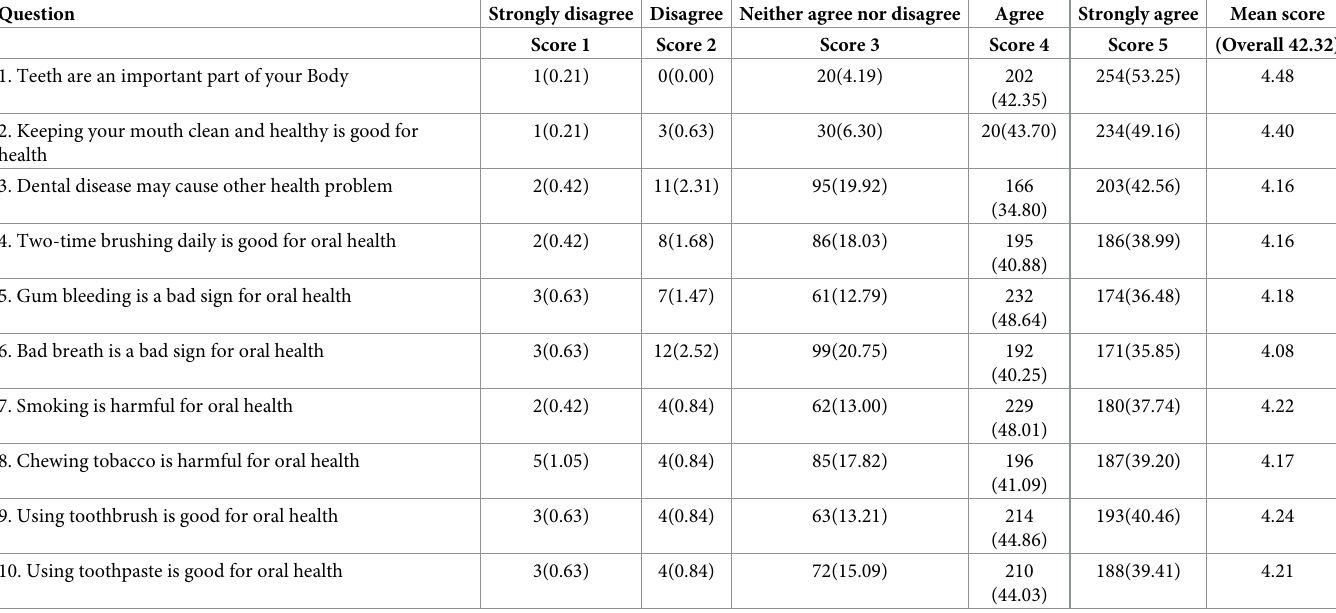
Table 2. Oral health knowledge of the participants (N = 477).